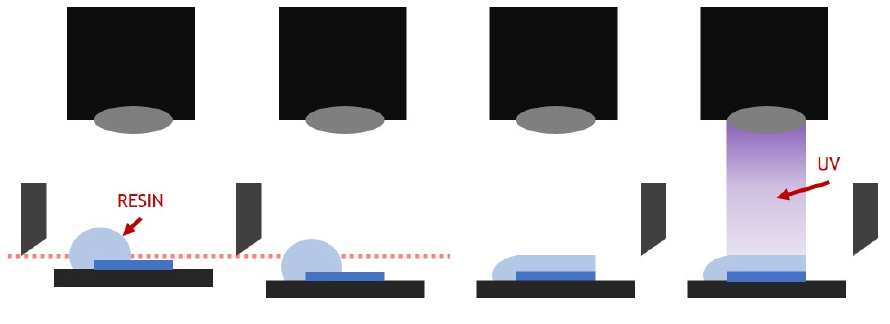
Figure 5. Printing